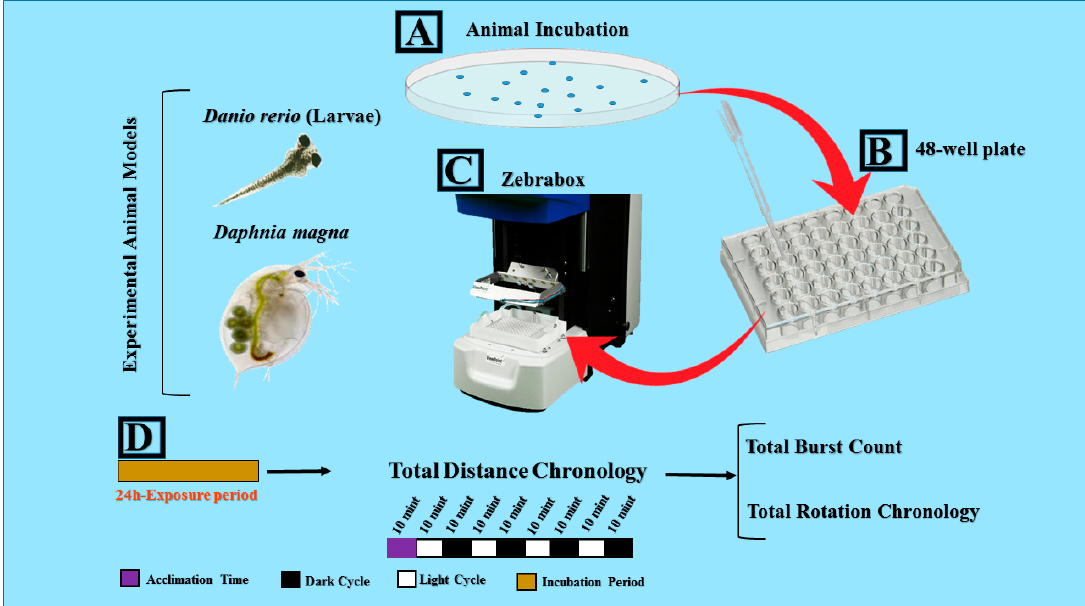
Figure 1. Locomotor toxicity assessment of pesticides by using both water flea ( Daphnia magna) neonates and zebrafish ( Danio rerio ) larvae. ( A ) Experimental animals were incubated in pesticide-containing solutions for ~24 h. ( B ) Experimental animals were then transferred to 48-well plate with the aid of a pipette. ( C ) ZebraBox behavioral observation instrument machine was used to perform high-throughput locomotor toxicity assays. ( D ) Experimental design and endpoints such as total distance traveled, total burst, and rotation movement, and alternating light / dark transition are